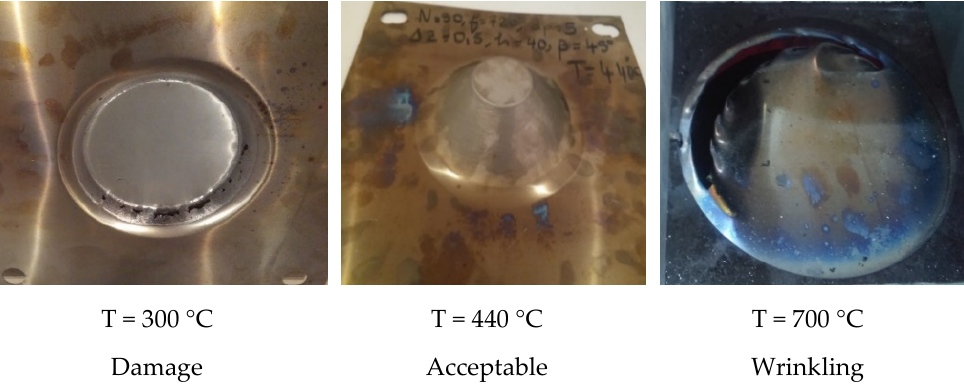
Figure 4. Truncated cones with a wall angle of 45° formed at different temperature.